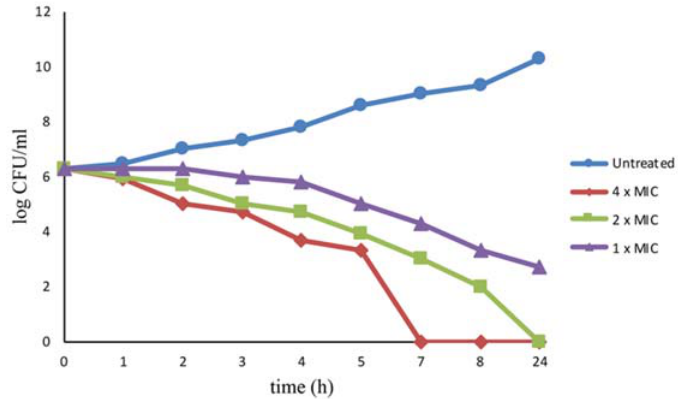
Figure 3. Killing kinetics for S. aureus ATCC 29213 following treatment with the L ‐ NPDNJ.